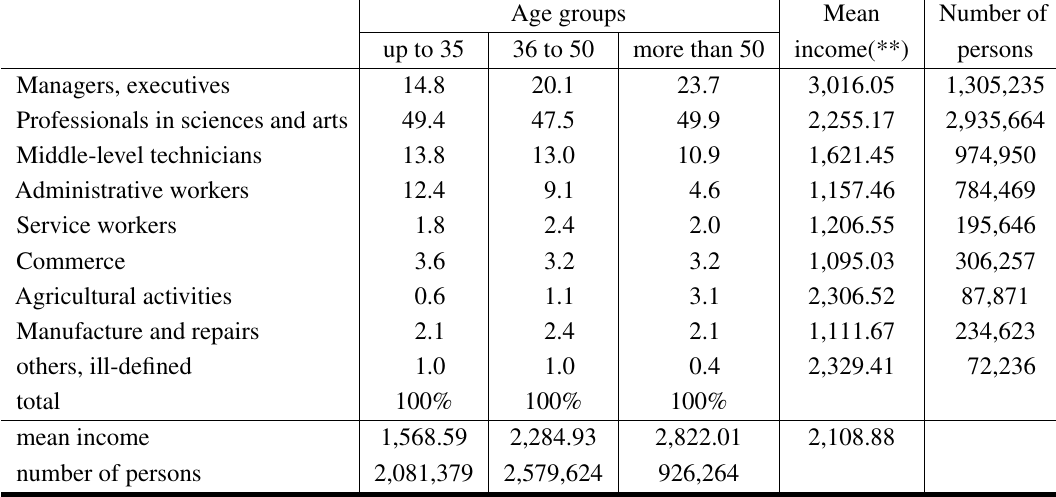
Brazil, occupation of persons with higher education(*), by age groups,